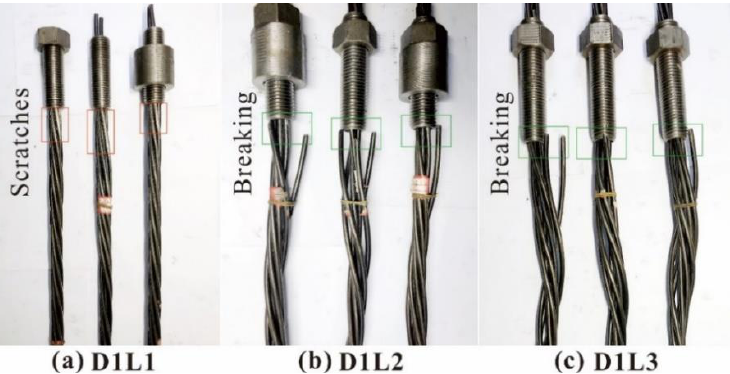
Figure 7. Failure mode of flexible bolt with Ø 30 mm locking casing: ( a ) D1L1, ( b ) D1L2, ( c ) D1L3.